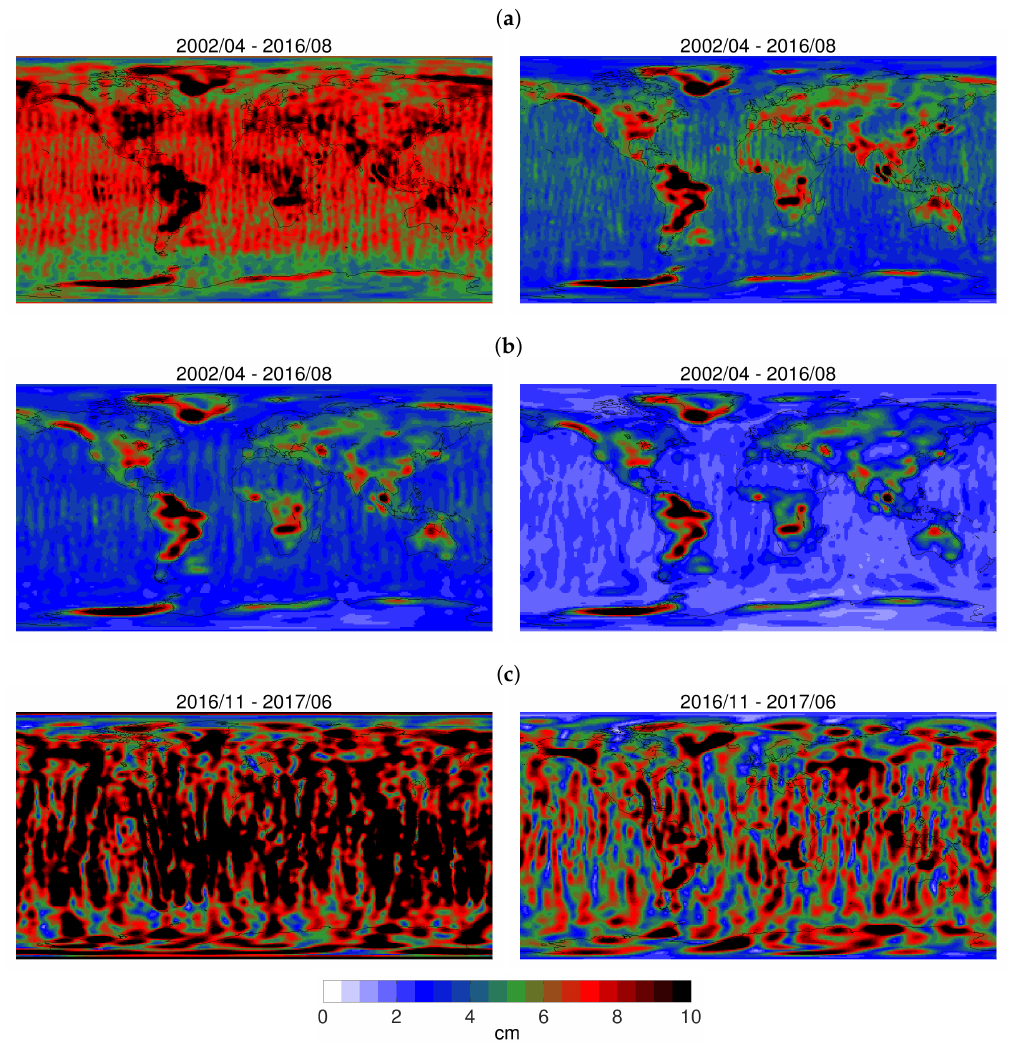
Figure 5. RMS of the time series of residuals (cm EWH) relative to a climatology model (without months regularized in RL05a) for GFZ RL05a (left) and GFZ RL06 (right); the following different cases are shown: period from 2002/04 through 2016/08, DDK5 filtered ( a ) and DDK3 filtered ( b ); and “GRACE single ACC” period, DDK3 filtered ( c